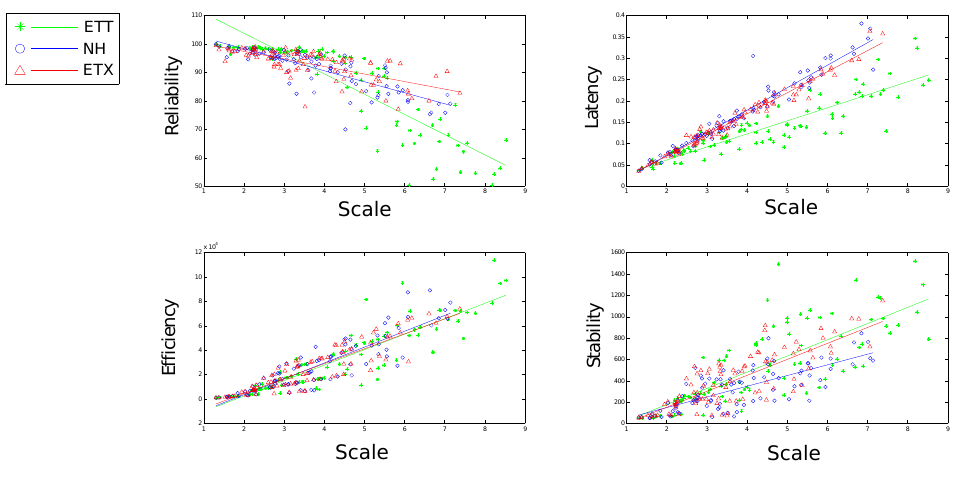
Figure 12. Network response from each solution as scale varies.